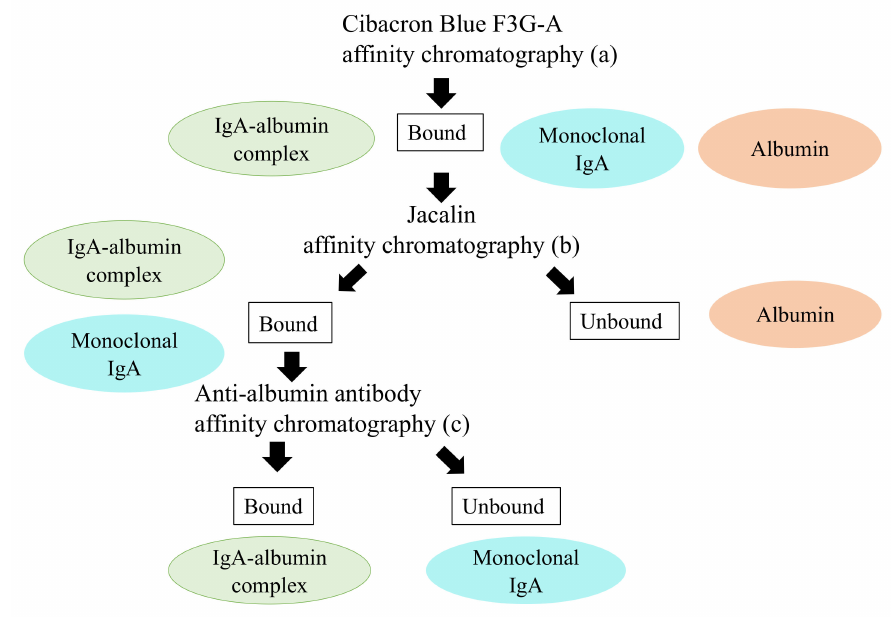
Figure 4. Procedure for purification of each protein from serum. Procedures are represented as ( a – c